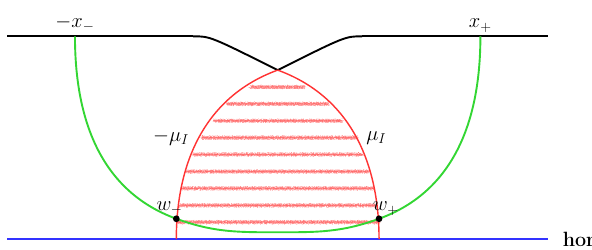
We draw here a single-sided boundary-to-boundary extremal geodesic curve starting from ( x (cid:0) ; t ) and ending on ( x + ; t ). This entangling geodesic intersects the (cid:0)